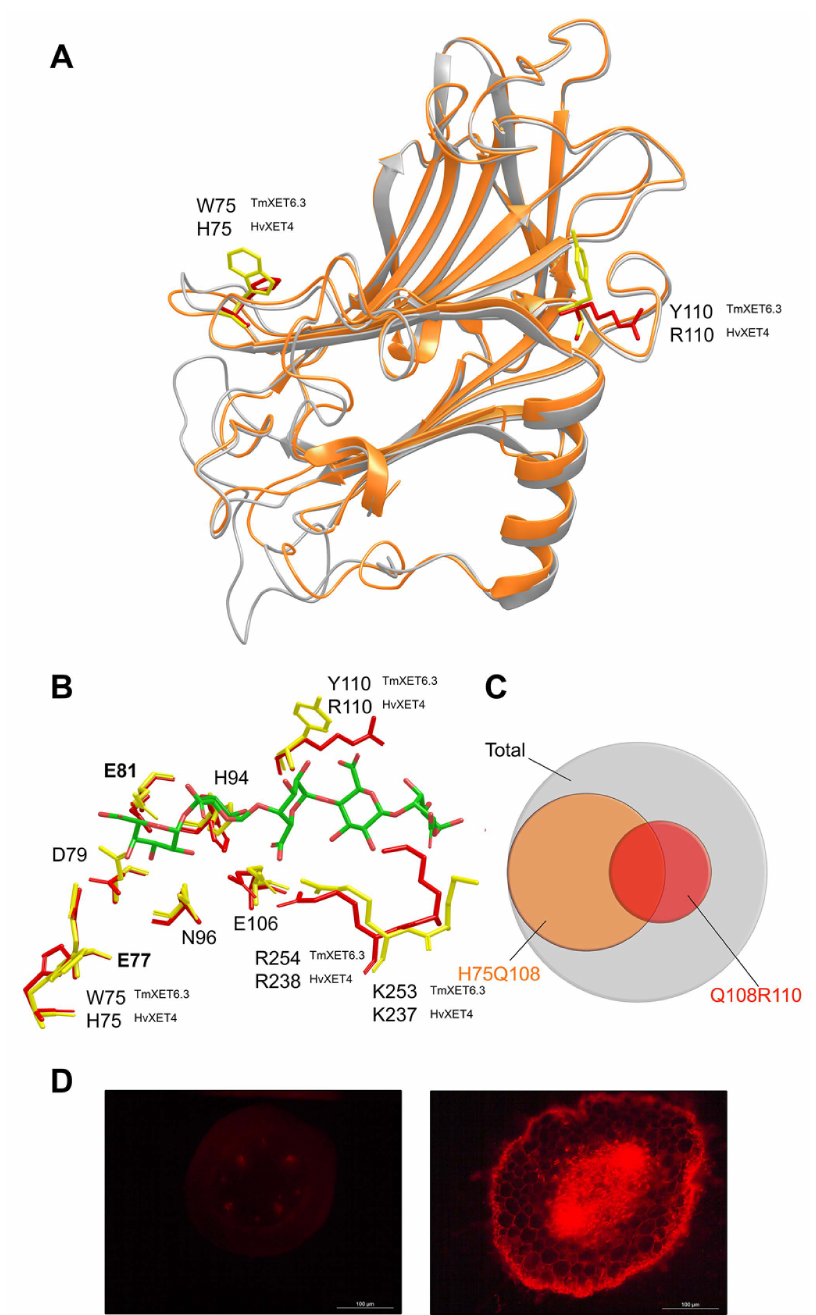
Figure 4. Structural basis of hetero-transglycosylation reactions catalysed by plant XETs with the negatively charged homogalacturonan [ α (1-4)GalA p ] 5 acceptor substrate. ( A ) 3D models of TmXET6.3 (orange) and HvXET4 (gray) indicate target amino acid residues destined for mutagenesis in TmXET6.3, to evoke the binding of the [ α (1-4)GalA p ] 5 acceptor and catalyse hetero-transglycosylation reactions with XG or HEC as donors, similarly to HvXET4 [125]; ( B ) interactions of [ α (1-4)GalA p ] 5 (cpk green) with the residues of HvXET4 (yellow sticks), where the corresponding residues in TmXET6.3 are indicated in red sticks; ( C ) Venn diagram of the occurrence of nonspecific XETs (with detailed residue configurations) with the potential to link XG or cellulose to ([ α (1-4)GalA p ] 5 ) based on the analysis of 3394 UniProtKB entries [125]; ( D ) incorporation of fluorescently labelled [ α (1-4)GalA p ] 5 into the stem (left) or root (right) cells of the nasturtium seedling. The pronounced labelling of root epidermal and vascular bundle CWs are visible, while no or little incorporation of [ α (1-4)GalA p ] 5 is seen in stem cells. Labelling was performed as described [125]. Scale-bar lengths are